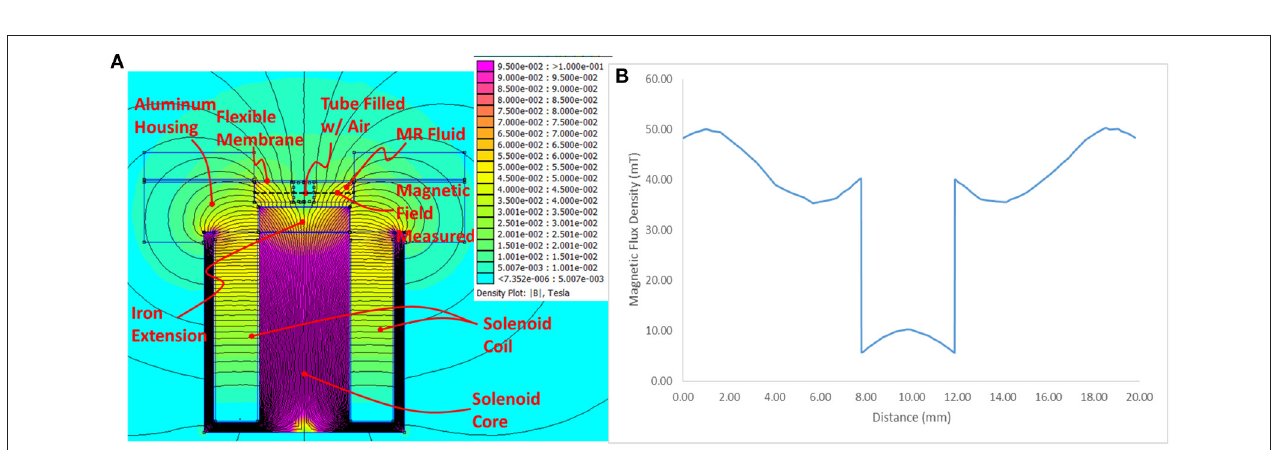
FIGURE 4 | FEMM simulation results: (A) Contour plot depicting the simulated magnetic field, (B) Magnetic field strength along the sample line.